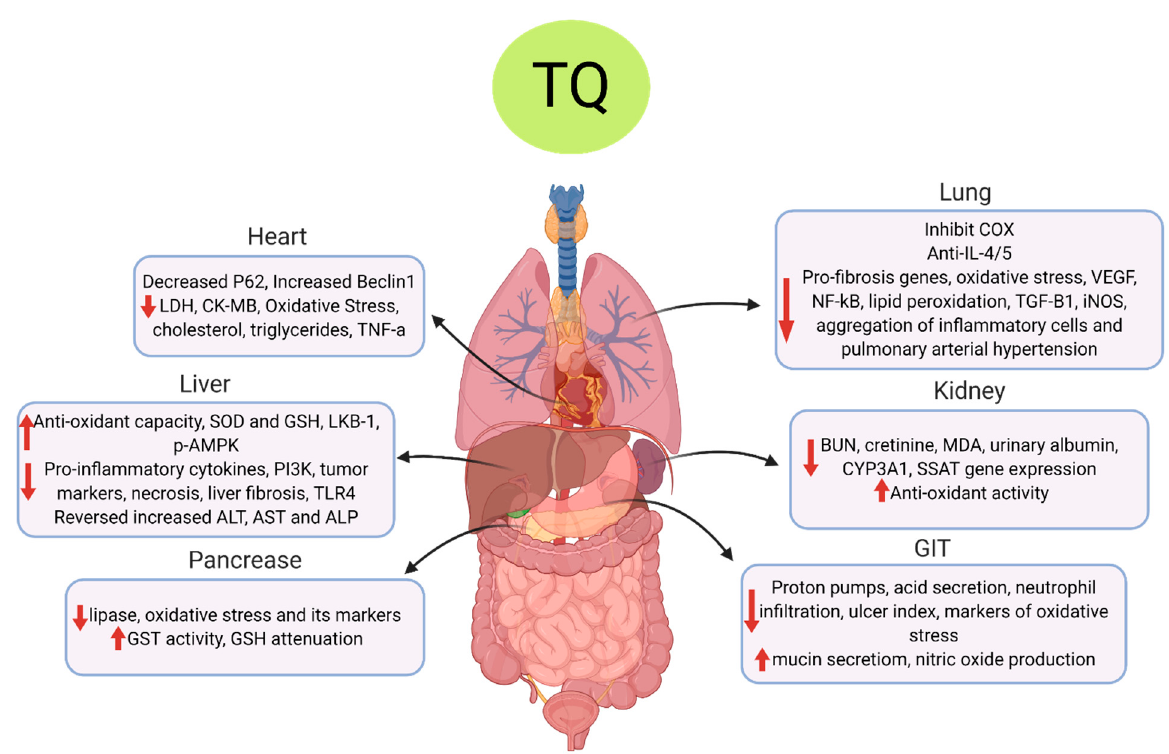
Figure 3. The multifunctional effects of TQ on COVID-19-associated pathophysiology. The diagram summarizes the main organ-related and organ protective effects of TQ on the main body organs. In the heart, TQ decreases cardiac enzymes, cholesterol, triglycerides and inflammatory cytokines. In the liver, TQ increases antioxidant enzymes and decreases proinflammatory genes and cytokines, elevated liver enzymes and liver fibrosis. In the pancreas, TQ increases antioxidant capacity by increasing glutathione-S-transferase (GST) enzyme and glutathione (GSH) levels while decreasing lipase and oxidative stress. In the lungs, TQ inhibits cyclooxygenase (COX) enzyme, IL-4/5 levels, NF-kB, vascular endothelial growth factor (VEGF), transforming growth factor- β 1 (TGF- β 1), oxidative stress, inducible nitric oxide synthase(iNOS) enzyme, lipid peroxidation, pro-fibrosis genes and pulmonary arterial hypertension;in the kidney, TQ decreases kidney markers, blood urea nitrogen (BUN), creatinine, malondialdehyde (MDA) and albumin and increases antioxidant activity. In the gastrointestinal tract (GIT), TQ inhibits proton pump, acid secretion, ulcer index, neutrophil infiltration and oxidative stress markers and increases mucin secretion and nitric oxide (NO) production.